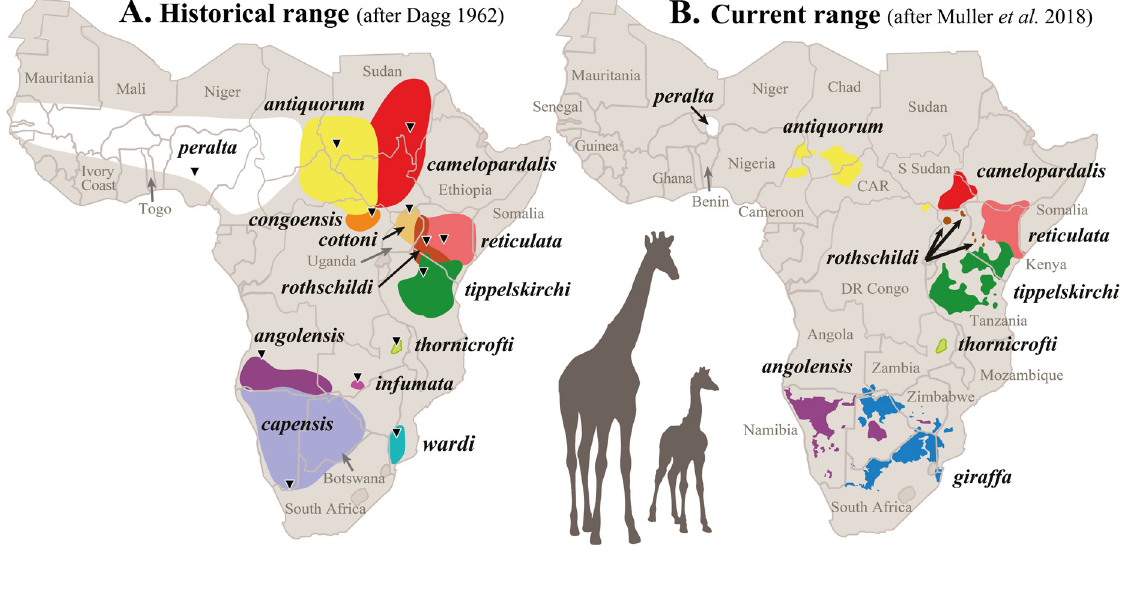
Fig. 1. Distribution range of giraffe subspecies. A . Within historic times (after Dagg 1962). B . At present (after Muller et al. 2018). The subspecies are distinguished by different colours on both maps, whereby the assignment of colours for the nine currently recognized subspecies (B) was modified from https://giraffeconservation.org/giraffe-species/ . The type locality for each subspecies is indicated by a triangle in map A and detailed in Table